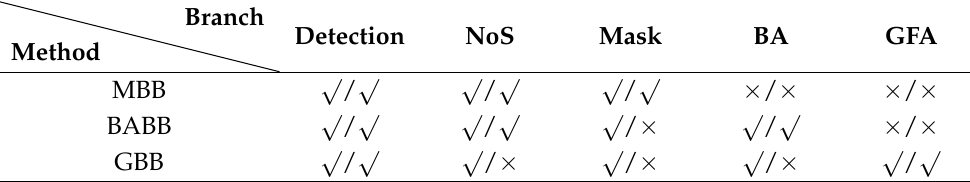
Table 1. Training/Inference Strategies of three